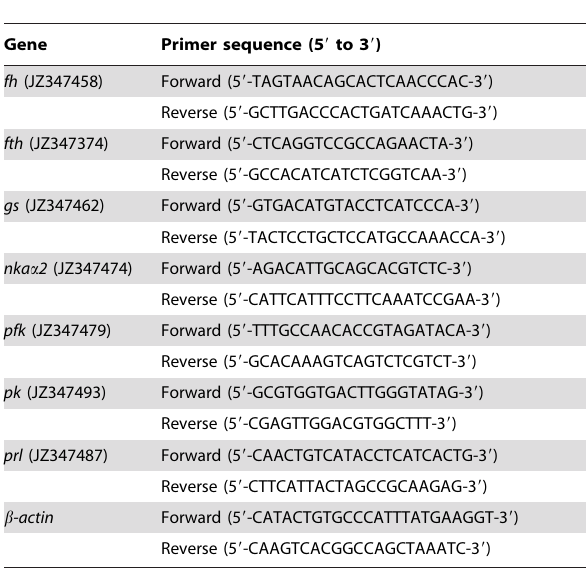
Table 1. Primers used for quantitative real-time PCR on fumarate hydratase ( fh ), ferritin heavy chain ( fth ), glutamine synthetase ( gs ), Na + /K + -ATPase a 2 ( nka a 2 ), phosphofructokinase ( pfk ), pyruvate kinase ( pk ) and prolactin ( prl ), with b -actin as the reference gene, from the brain of Protopterus annectens